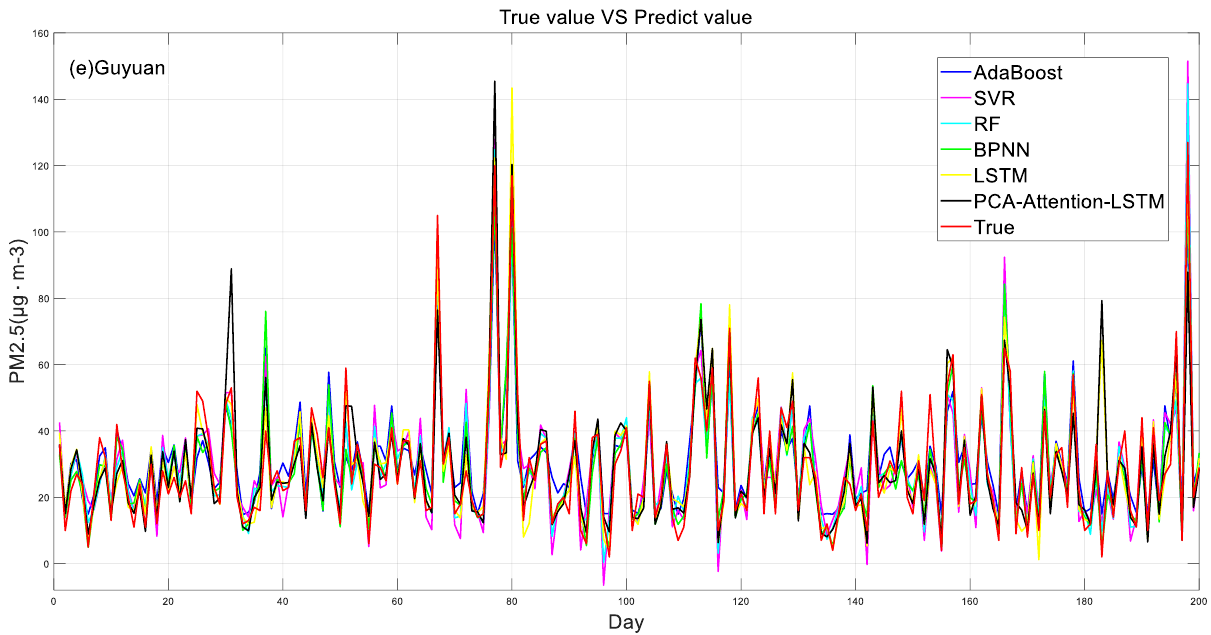
Figure 8. True value versus predicted value. ( a ) Wuzhong; ( b ) Yinchuan; ( c ) Zhongwei; ( d ) Shi- zuishan; ( e ) Guyuan. Table 4. Model evaluation results.